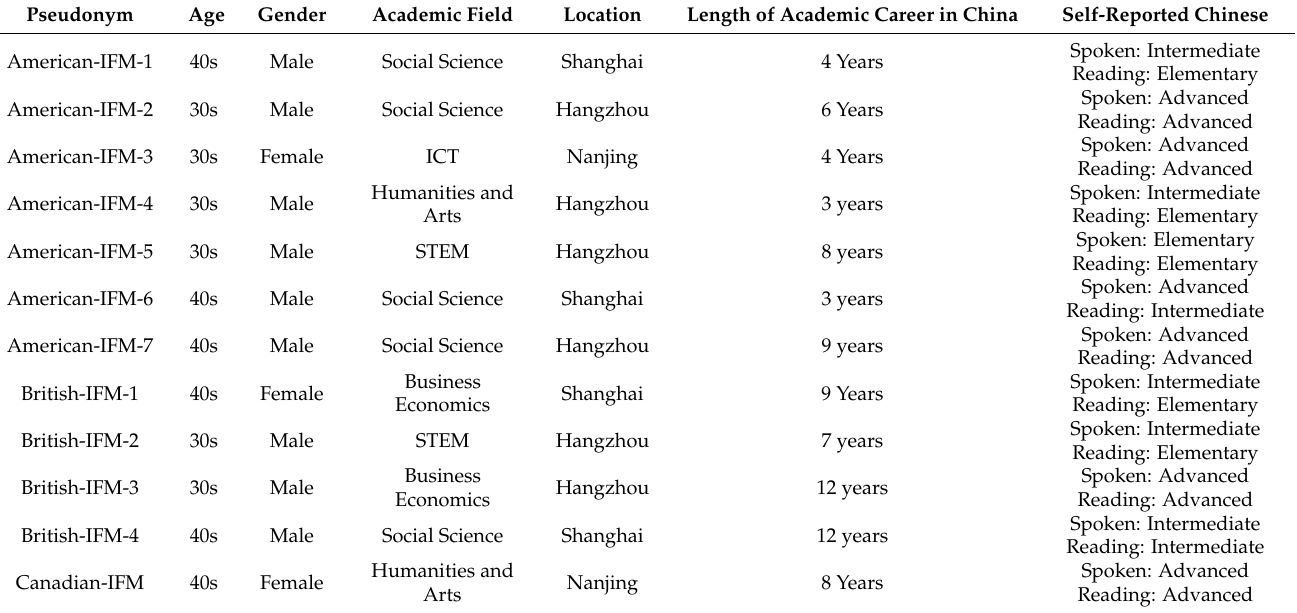
Table 1. Demographic Information of the